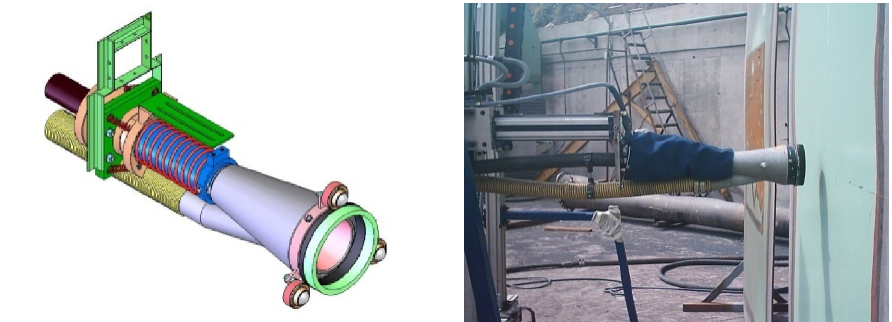
Figure 14. Blasting and suction